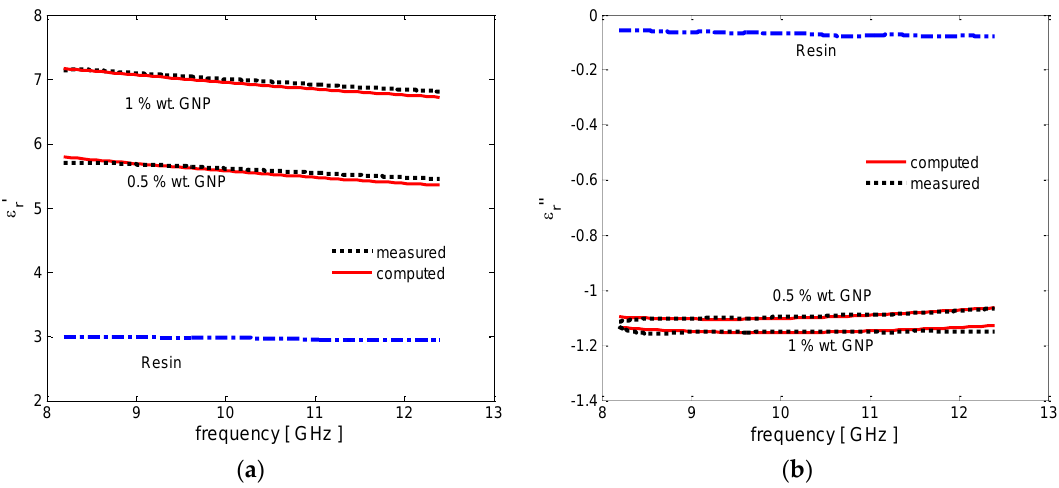
Figure 8. Complex effective permittivity of the GNP-filled epoxy-based composites with increasing filler concentrations: ( a ) real part and ( b ) imaginary part.